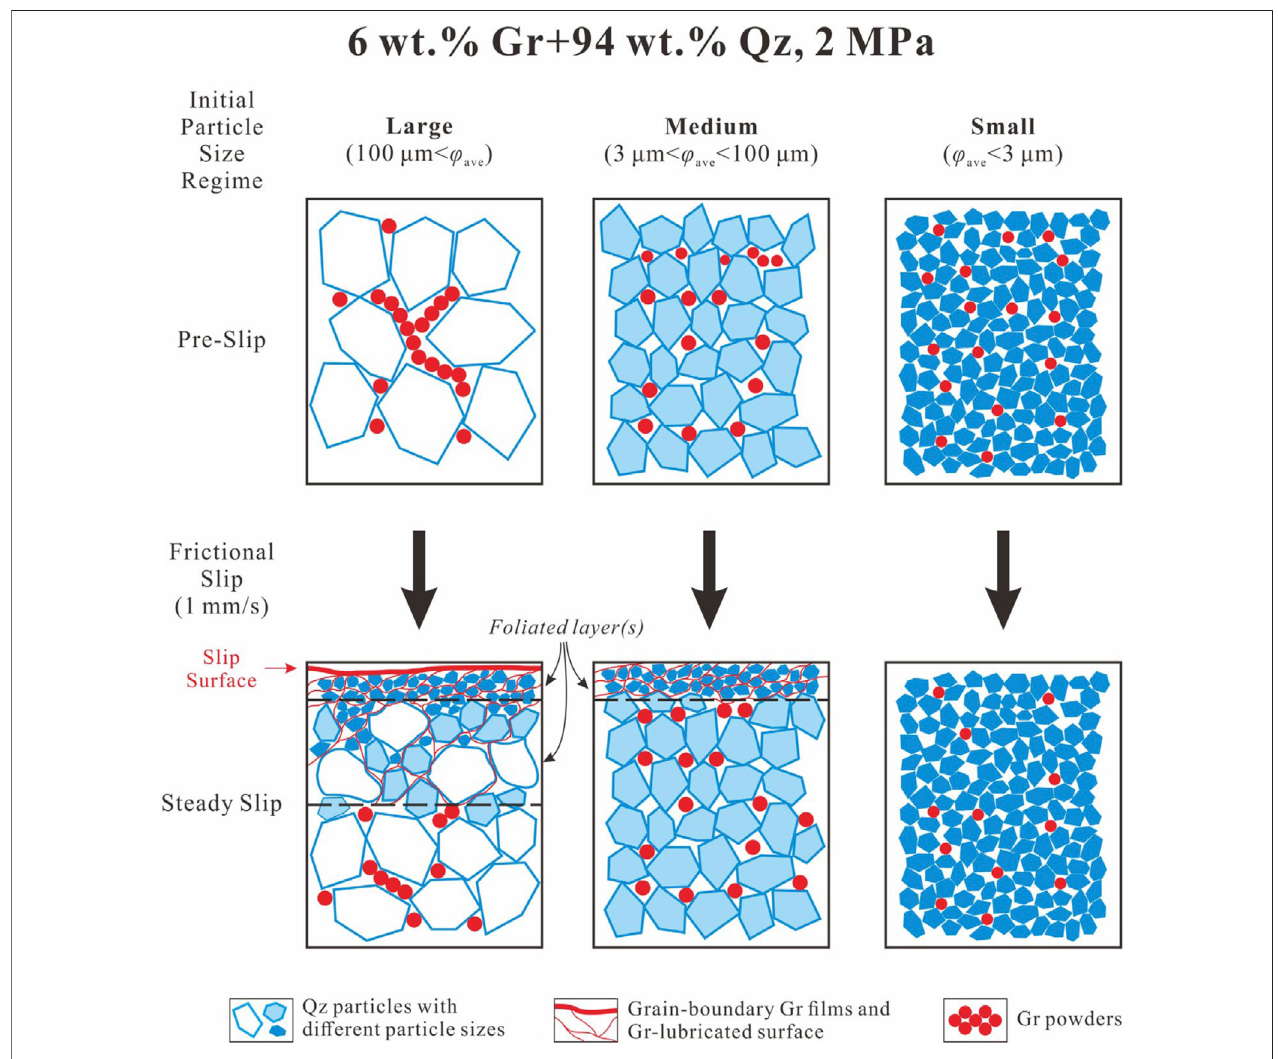
FIGURE7| Schematic diagram (not drawnto scale) ofthemicrostructural evolution ofdry synthetic Gr-bearing gougesunder2 MPabefore and after frictional slip at 1 mm/s, including large, medium, and small particle size regimes.